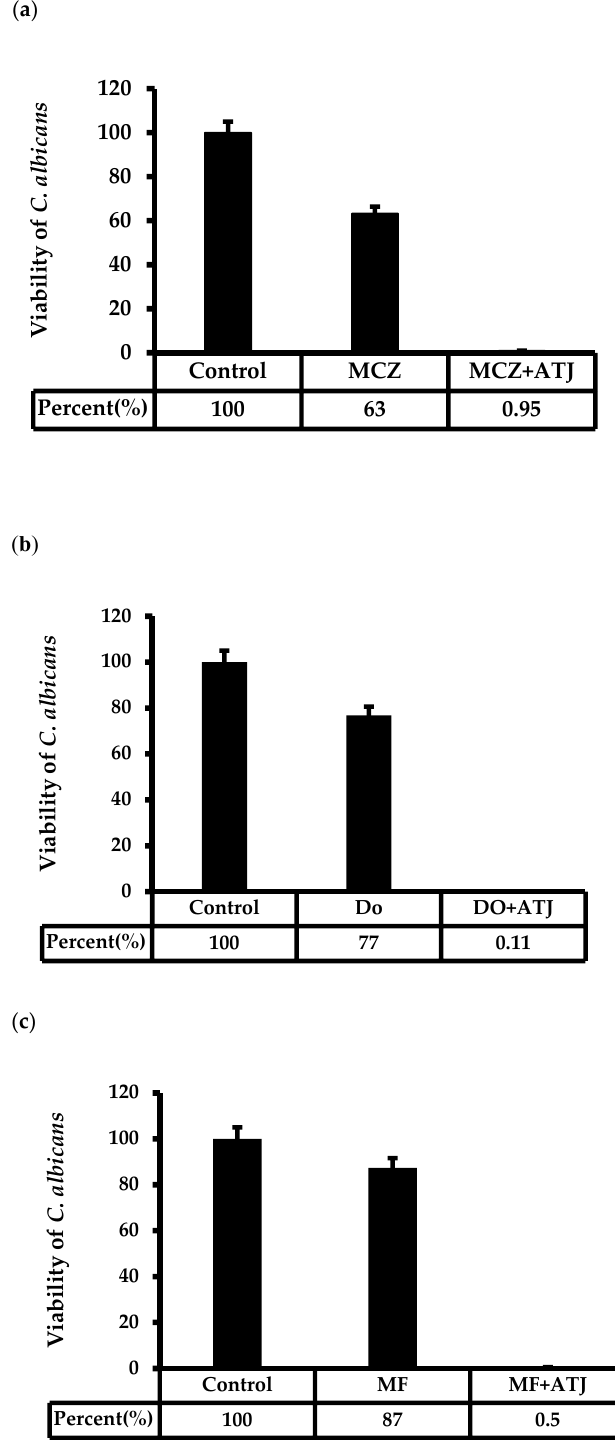
Figure 3. A. triphylla var. japonica increased the susceptibility of antifungal agent. A. triphylla var. japonica extract (6.25 µ g/mL) was treated to C. albicans with ( a ) miconazole (3.125 µ g/mL), ( b ) dioscin (3.125 µ g/mL), and ( c ) magnoflorin (3.125 µ g/mL). Biofilm formation was induced for 24 h by growing of C. albicans in the RPMI1640. MCZ: Miconazole, MF: Magnoflorine, Do: Dioscin, ATJ: A. triphylla var. japonica extract. Experiments were performed in